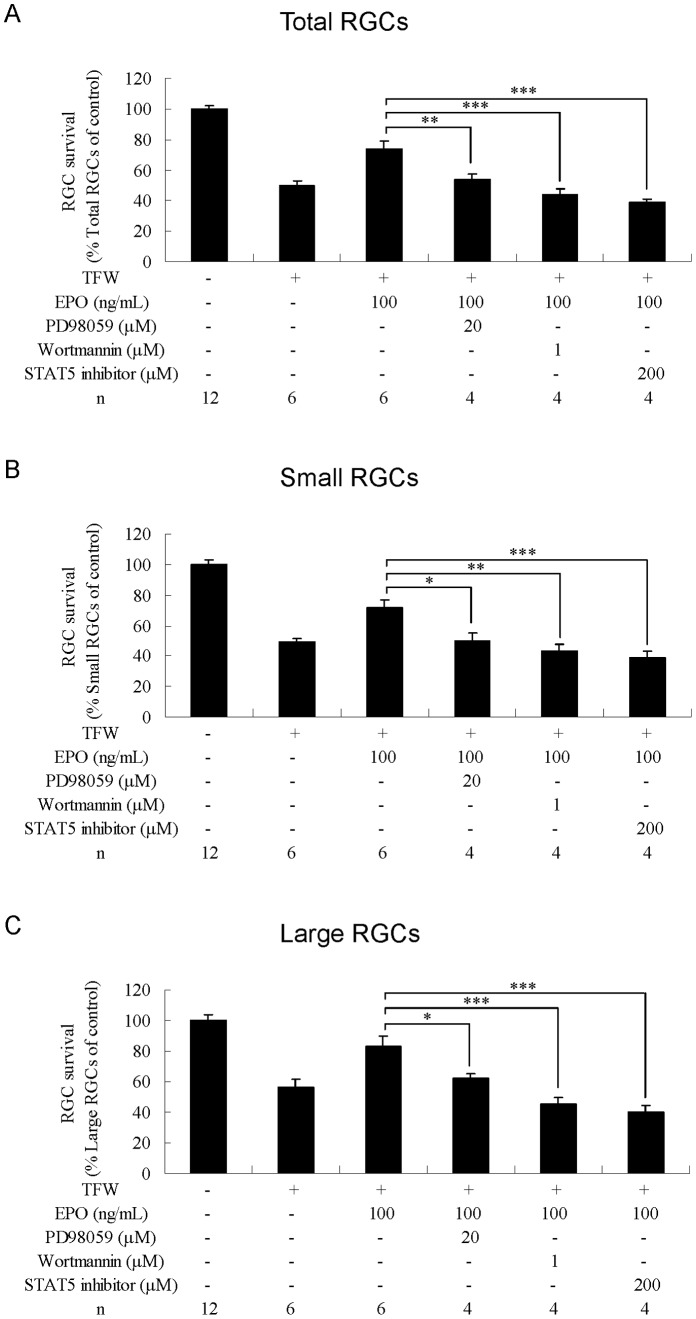
Effects of combined treatment with erythropoietin and kinase inhibitors on RGCs under TFW-induced toxicity.Survival rates of (A) total, (B) small, and (C) large RGCs were estimated as percentages of the control. Data are presented as mean ± standard error of the mean (n = 6–12). Data were statistically analyzed by 1-way ANOVA, followed by the Dunnett’s test. *P<0.05, **P<0.01 and ***P<0.001.